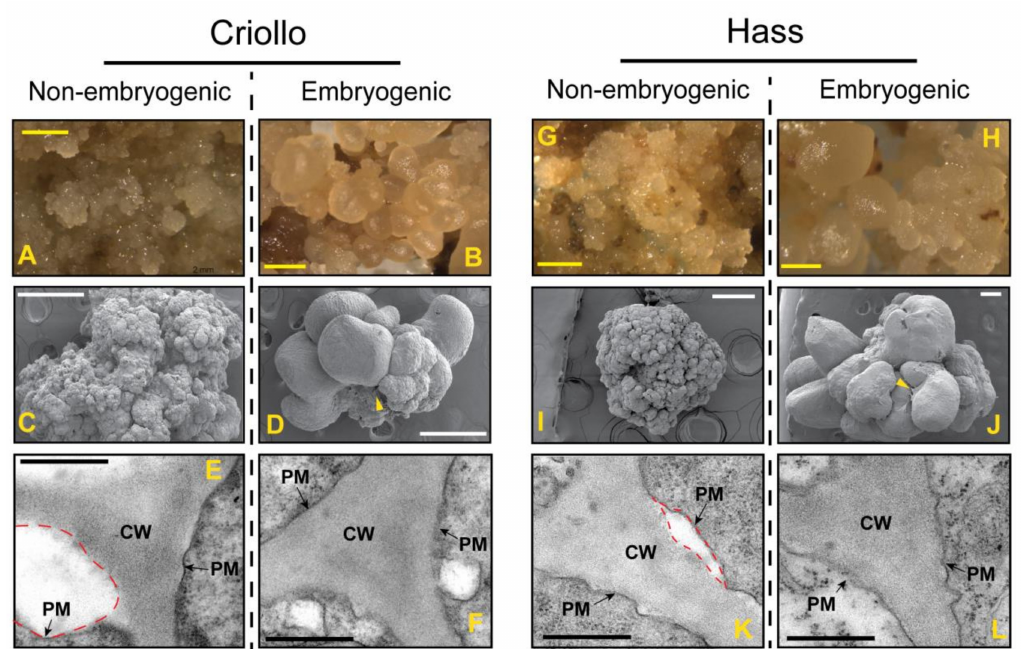
Figure 1. Phenotypes of non-embryogenic (NEC) and embryogenic (EC) cultures of avocado. Light microscopy ( A , B , G , H ), scan electron microscopy (SEM, C , D , I , J ) and transmission electron microscopy micrographs (TEM, E , F , K , L ) display contrasting di ff erences between EC ( B , D , F , H , J , L ) and NEC ( A , C , E , G , I , K ) both in Criollo ( A – F ) and Hass ( G – L ) cultures. Yellow scale bars in ( A ), white scale bars in ( B ), and black scale bars in ( C ) denote 1 mm, 250 µ m, and 500 nm, respectively. Yellow arrowhead indicates the extracellular matrix surface (EMSN) in ( D , J ). PM and CW indicate in ( C ) plasma membrane and cell wall, respectively. Dash red lines in ( C ) specified detachments of the PM from the cell